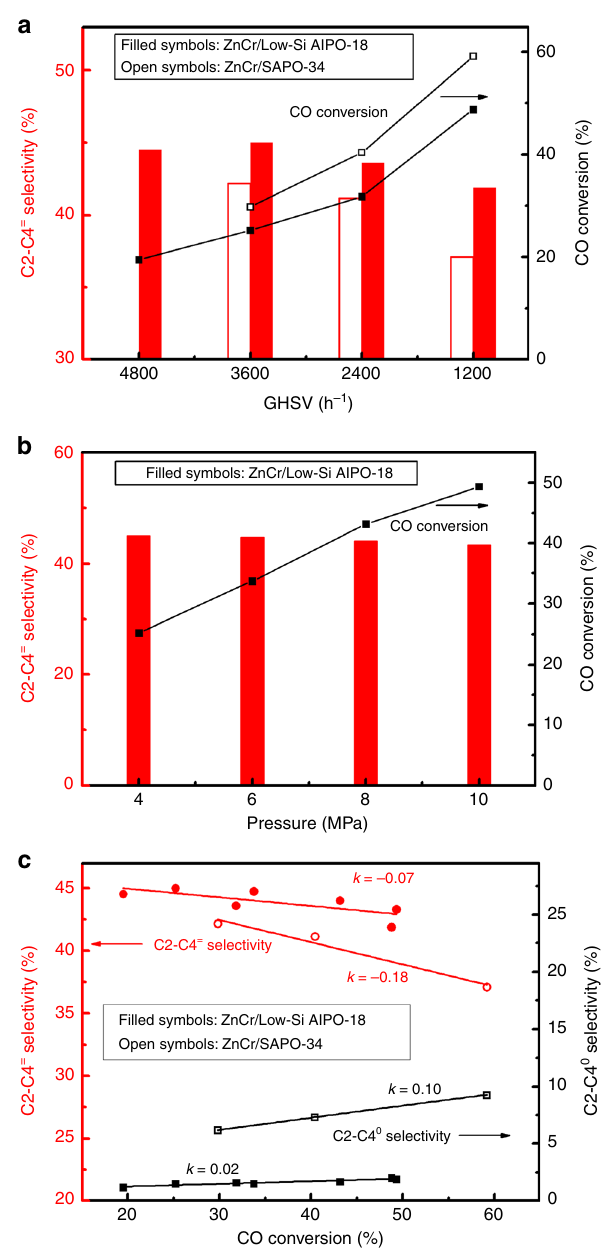
Fig. 3 Effect of reaction conditions on catalytic performance. a Effect of GHSV on CO hydrogenation over ZnCr/low-Si AlPO-18 and ZnCr/SAPO- 34 bifunctional catalysts; Other conditions: 390 °C, 4.0 MPa, H 2 /CO = 1. b Effect of pressure on CO hydrogenation over ZnCr/low-Si AlPO-18 bifunctional catalysts; Other conditions: 390 °C, 3600 h − 1 , H 2 /CO = 1. c Relation between CO conversion and C2 – C4 product selectivity (ZnCr/low-Si AlPO-18: fi lled symbols, ZnCr/SAPO-34: open